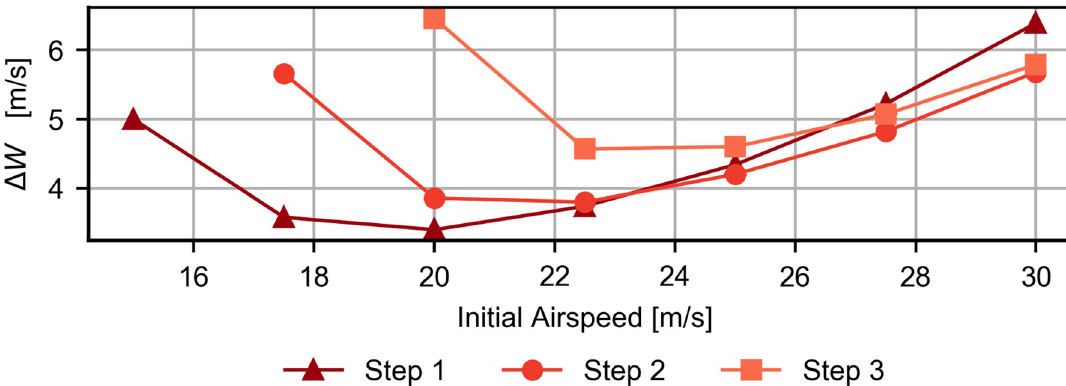
Fig 12. Effect of the initial airspeed. Evolution of the required wind strength as a function of the initial airspeed for three different step- wind profiles with b = 5, 10 and 15, and k = 0.5.